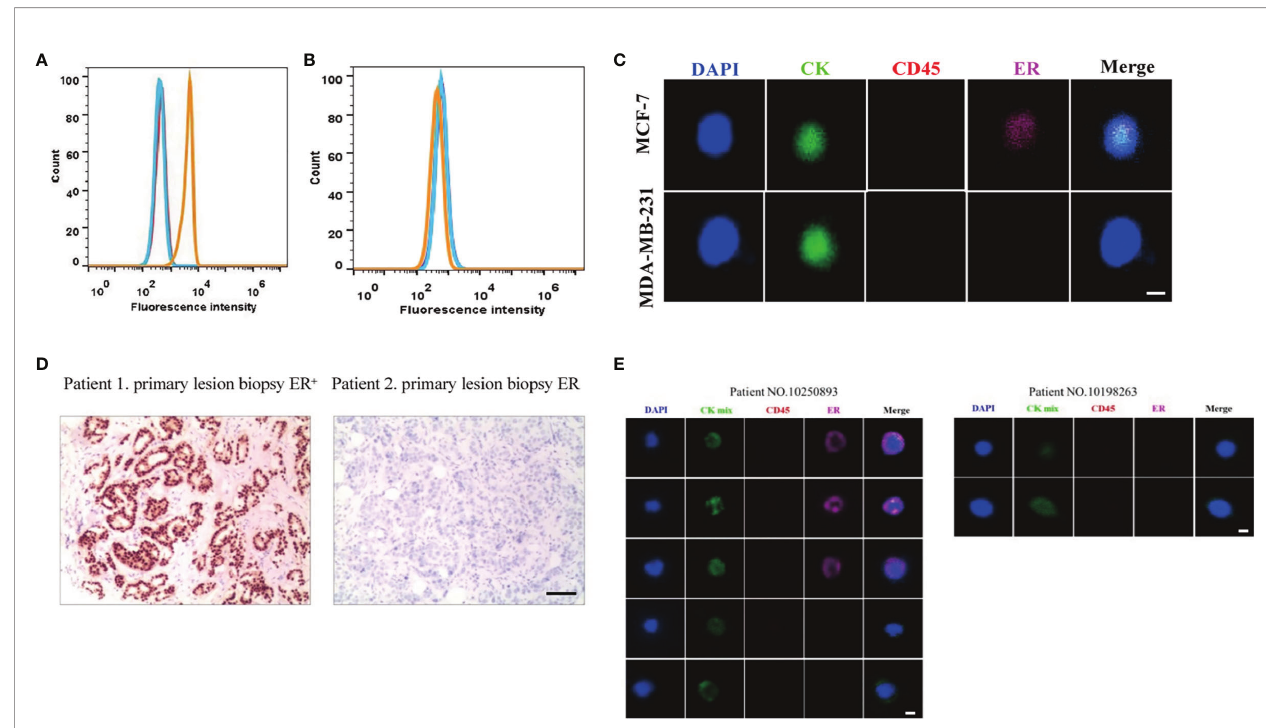
FIGURE 1 | Establishment of ER quantitative analysis systems in BC cell lines and patient samples. (A, B) As shown by FACS, the fl uorescence signal for ER was strong in MCF-7 BC cells (A) , but there was no signi fi cant signal in MDA-MB-231 BC cells (B) . Blue lines, unstained cells. Orange lines, stained cells. (C) MCF-7 BC cells were positive for ER, and MDA-MB-231 BC cells were negative for ER under a fl uorescence microscope. (D) Based on the primary tumor IHC results, one patient was positive for ER while another patient was negative for ER. (E) Based on the Pep@MNPs method, one patient had both ER-positive CTCs (CTC ER+ ) and ER-negative CTCs (CTC ER- ), while another patient only had ER-negative